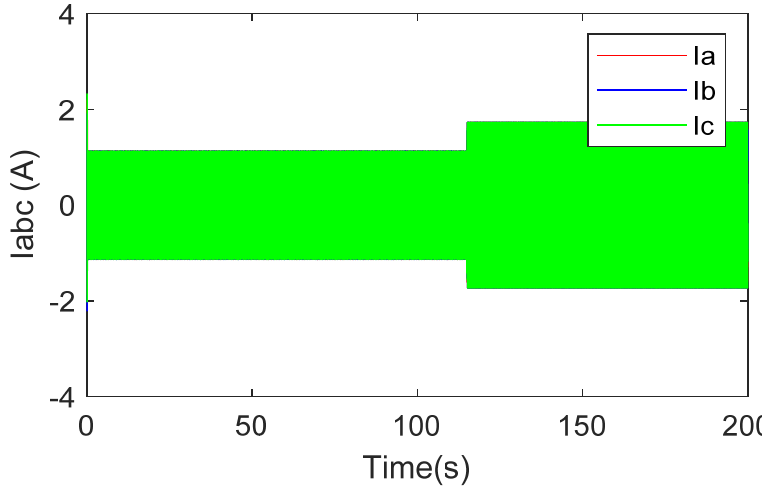
Figure 7. Three-phase PMSG currents with variable reference.